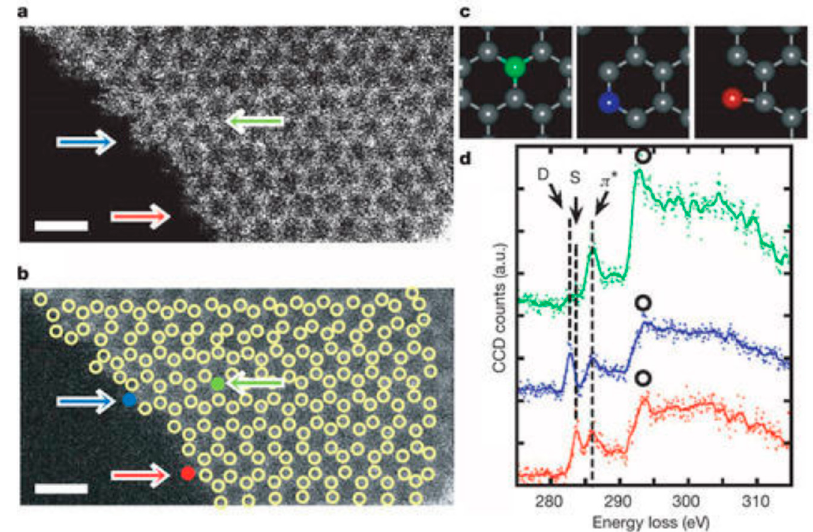
Figure 11. Imaging and spectroscopy of a graphene edge, from work by Suenaga and Koshino. Reproduced with permission from [80]. Springer Nature, 2010. ( a ) Unprocessed ADF image of single graphene layer; Atomic positions are marked by circles in smoothed image ( b ). Scale bars, 0.5 nm. ( d ) ELNES of carbon K (1 s) spectra taken at the colour-coded atoms indicated in ( b ). Green, blue, and red spectra correspond to the normal sp 2 carbon atom, a double-coordinated atom and a single-coordinated atom, respectively. These different states of atomic coordination are marked by coloured arrows in ( a , b ) and illustrated in ( c ).